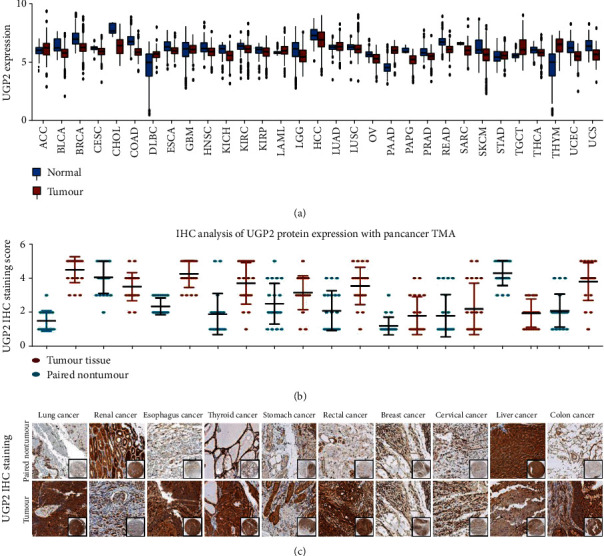
UGP2 expression is frequently dysregulated in cancer. (a) UGP2 mRNA expression level from the TCGA dataset compared with normal tissues. (b) UGP2 protein expression in pancancer tissues and paired nontumour tissues. (c) Representative UGP2 histological scoring in pancancer tissues and paired nontumour tissues. UGP2: uridine diphosphate-glucose pyrophosphorylase 2; TCGA: The Cancer Genome Atlas.